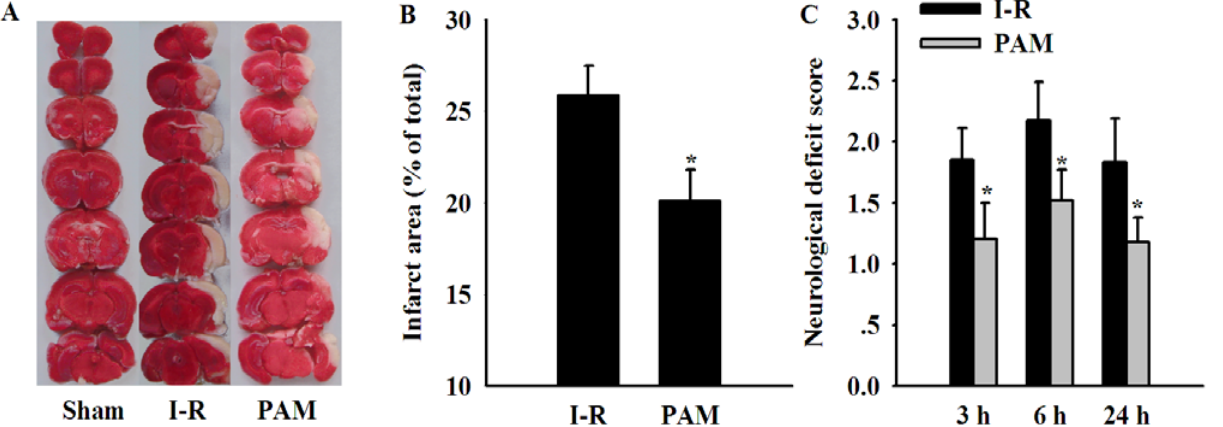
Figure 5. Effects of PAM 10 mg/kg on cerebral infarct area and neurological deficit